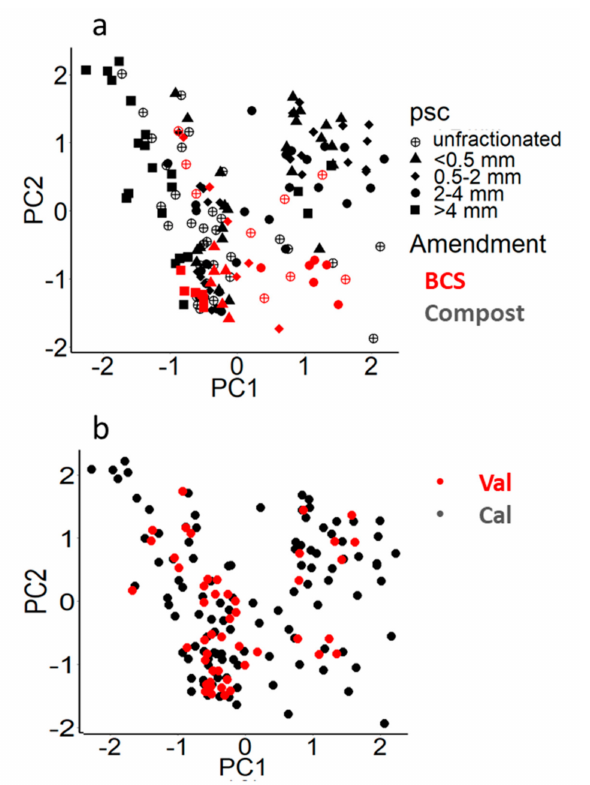
Figure 6. ( a ) PC1 and PC2 scores of OA samples and particle size classes (psc’s) and ( b ) PC1 and PC2 scores of OA calibration (black) and validation (red) samples (BCS and